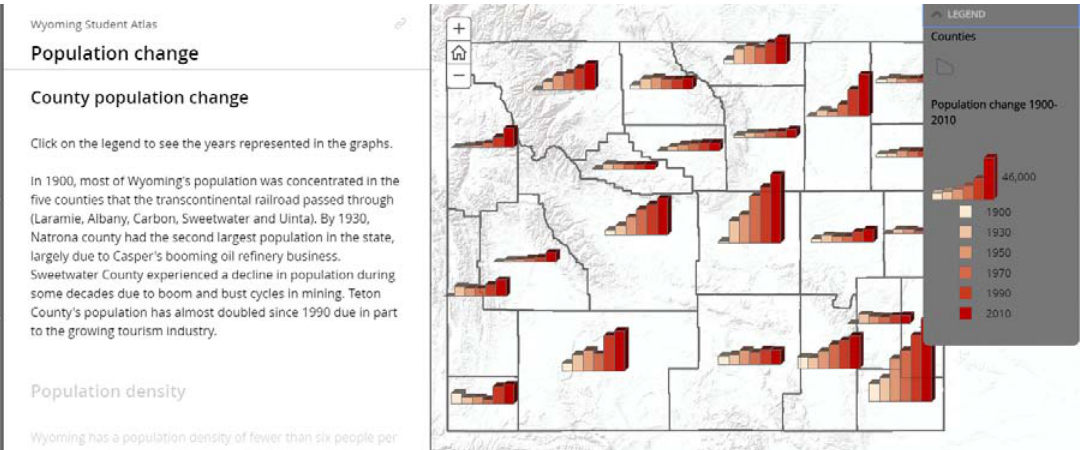
Figure 1. An example of a complex cartographic representation (charts as proportional symbols) in a web map embedded within an atlas story map.